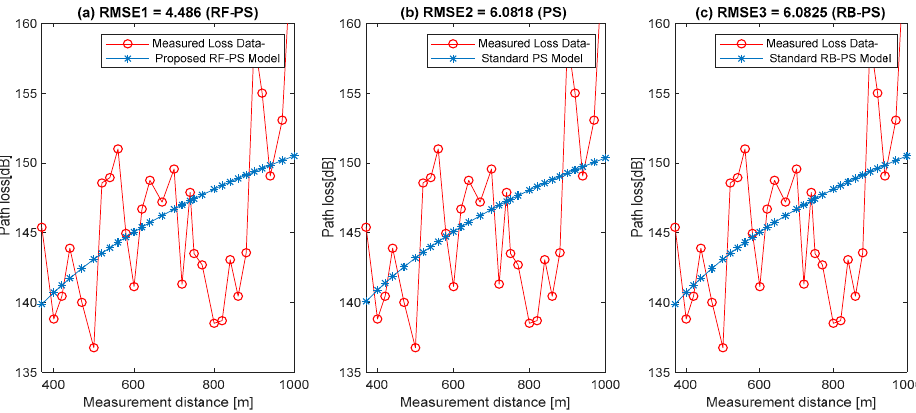
Figure 9. Results showing the measured path loss versus distance using the hybrid RF-PS method and two existing standard path loss prediction methods in site 2 of location 1.